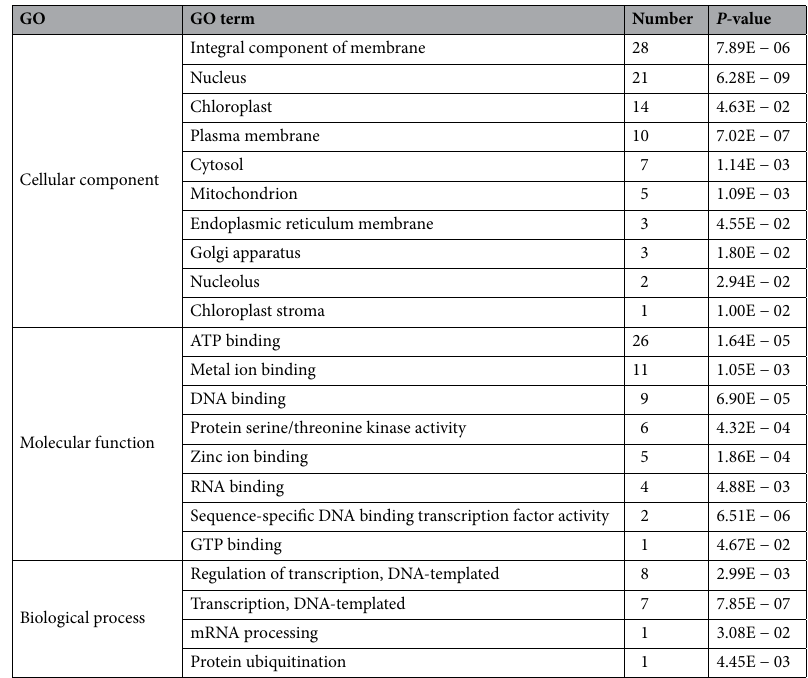
Table 5. GO function enrichment analysis of 301 common differentially expressed genes of cultivated and wild peach